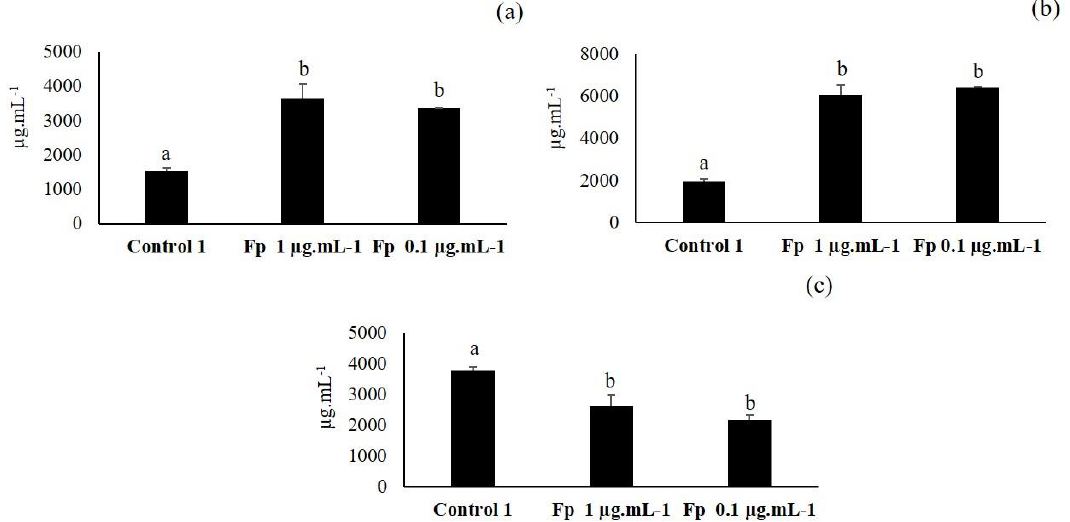
Figure 7. Daidzin ( a ), genistin ( b ) and malonyl genistin ( c ) production in the seeds inoculated with the purest fraction (Fp) obtained from F1.1 and in control 1 seeds. The amount of isoflavones is expressed in µ g · mL − 1 ( n = 30 soybean seeds × 3 replicates). Di ff erent letters show significant statistical di ff erences between treatments in each isoflavone ( p < 0.05). Error bars correspond to standard deviation (SD).